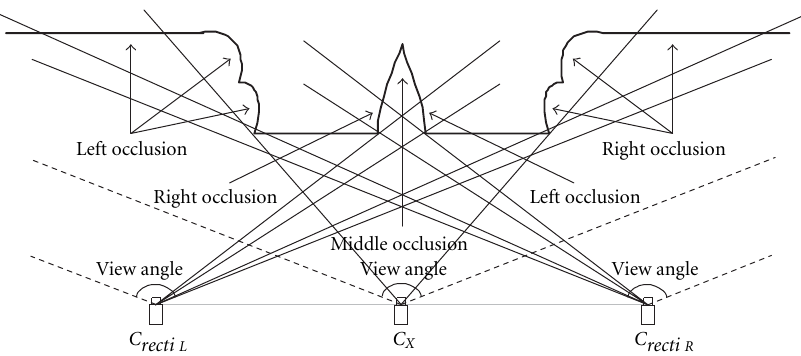
Figure 9: Top view about three parallel cameras imaging a 3D scene. The bold curve indicates the scene surface from the viewpoint of the three cameras C recti L , C recti R , and C X . The left occlusion areas appear in V recti L but not in V recti R . The right occlusion areas appear only in V V recti R but not in recti L . The complete 3D areas appear both in While the middle occlusion areas only appear in V X but neither in V recti L nor in V recti R